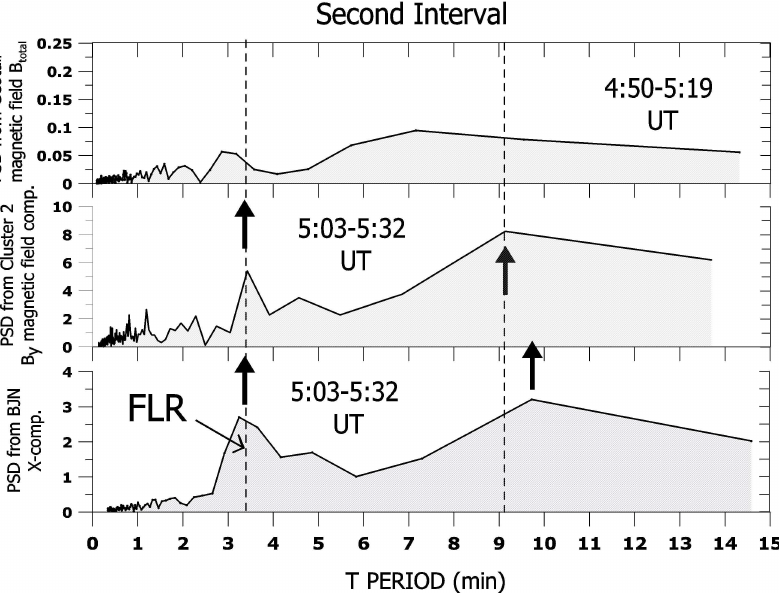
Fig. 11. For the “second interval” 05:03–05:32 UT the PSDs are presented with the same format as in Fig. 10. The BJN station shows the resonant frequency of T=3.5min,